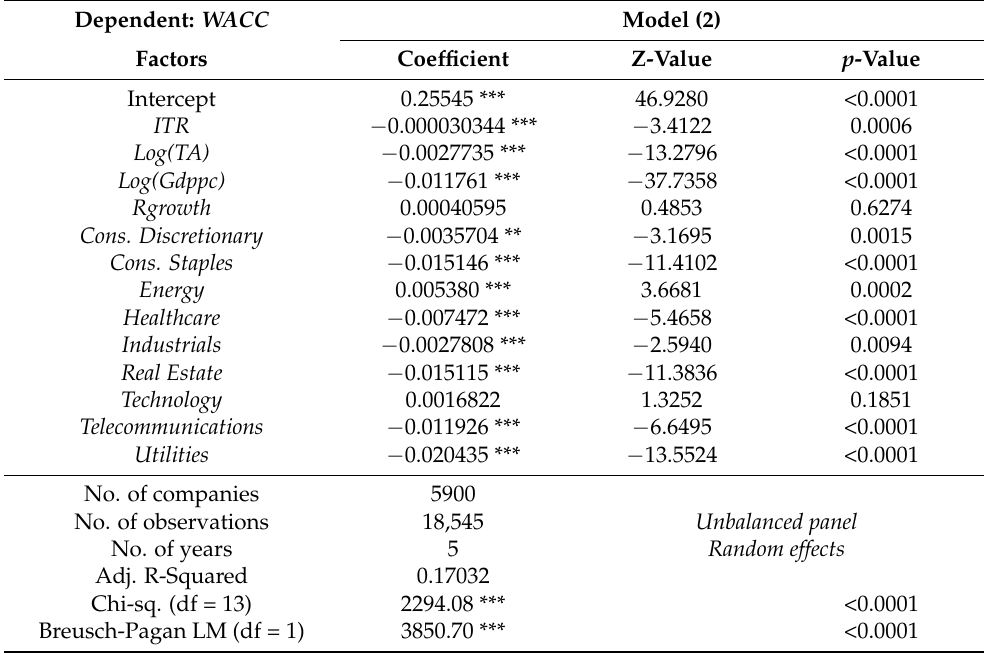
Table 7. Panel regression results for the weighted average cost of capital ( WACC) as the dependent variable.